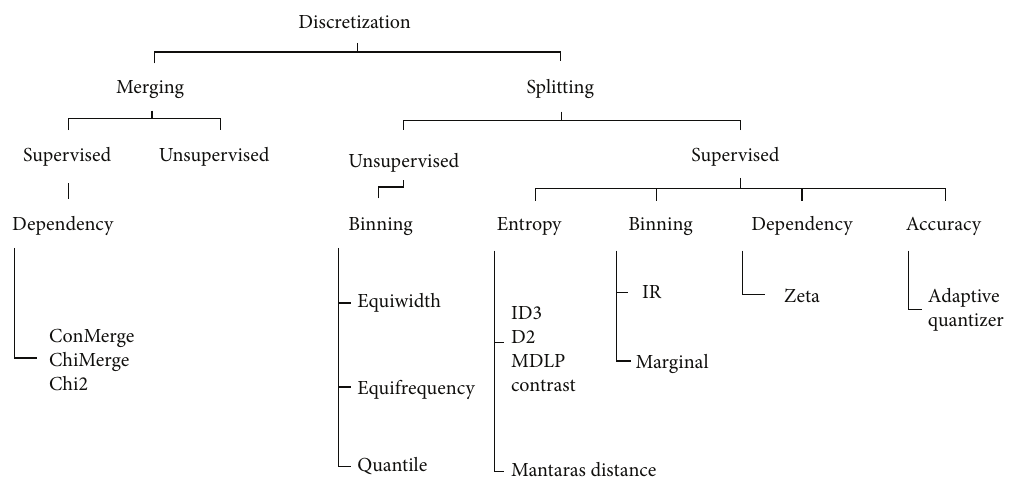
Figure 1: Proposed framework.